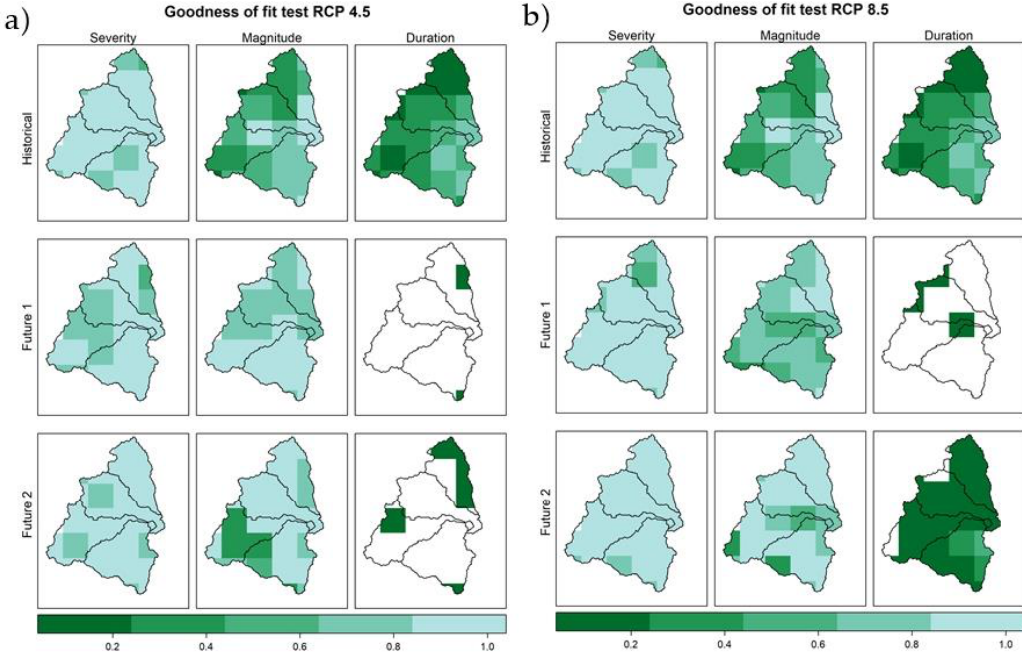
Figure A1. p -values of the goodness of fit test for GEV distribution in ( a ) RCP 4.5 and ( b ) 8.5 (base period and Future 1 and 2). White color indicates zones where the p -value is less to 0.05.